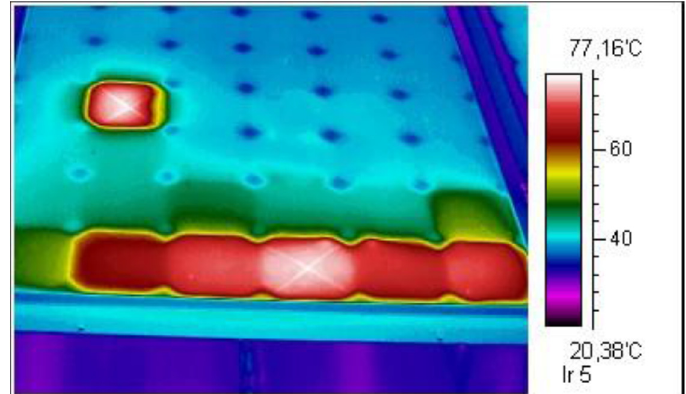
Figure 16. PV panels with hot spots